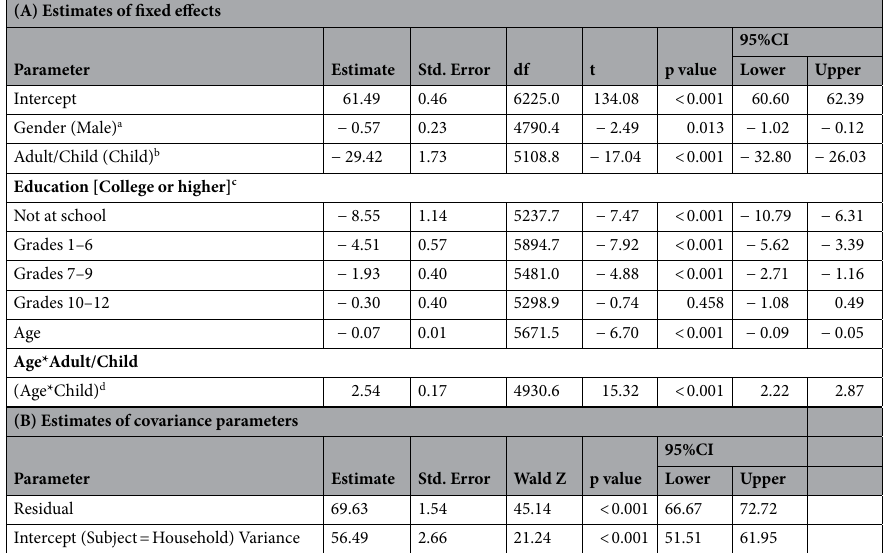
Table 4. Estimates of fixed and random effects for knowledge score (percentage). a Reference group: Females. b Reference group: Adults. c Reference group: College. d Reference group: